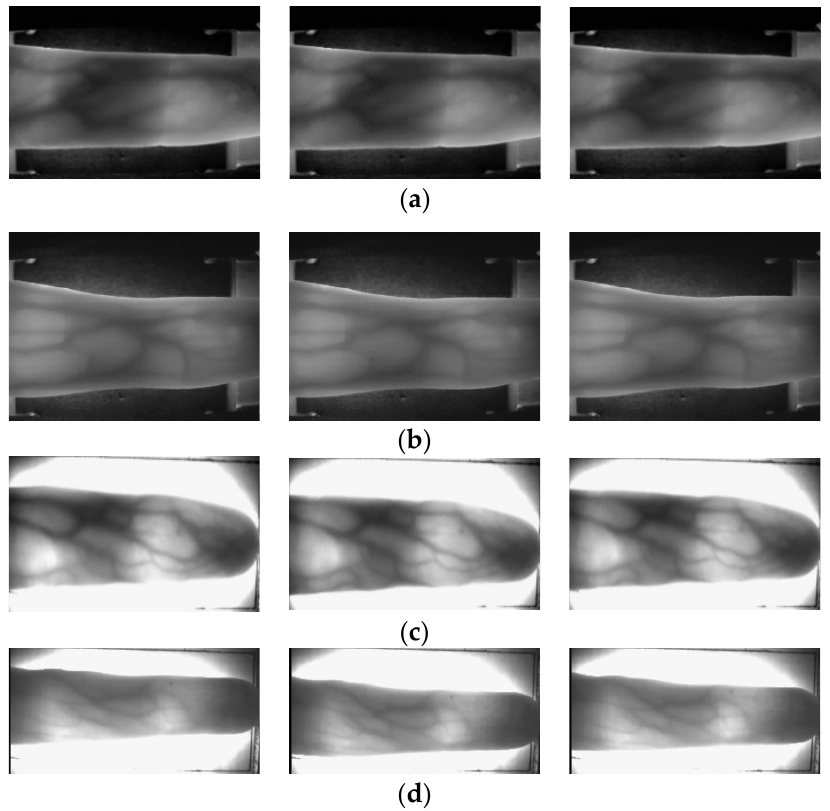
Figure 6. Examples of images obtained from the same finger. ( a , b ) SDU-DB and ( c , d )